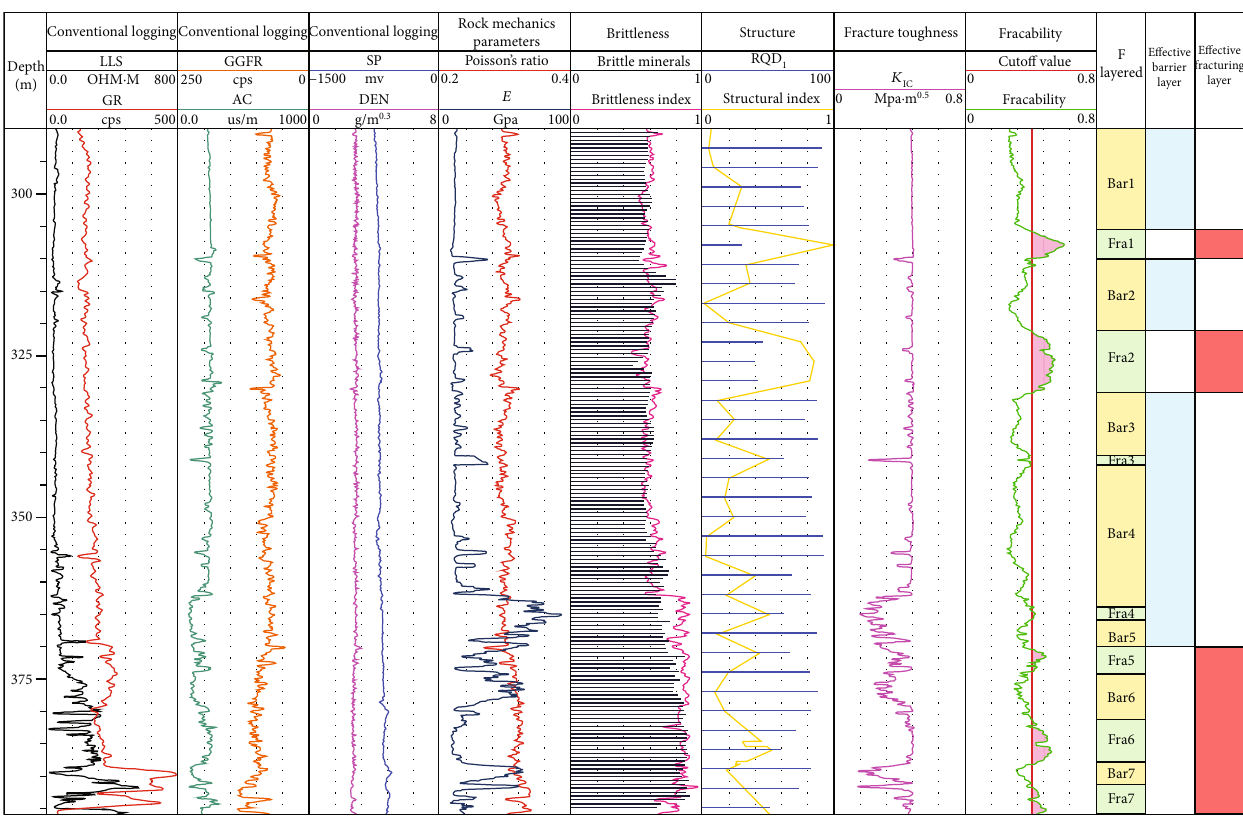
Figure 13: Comparison with Jin ’ s fracability (where F